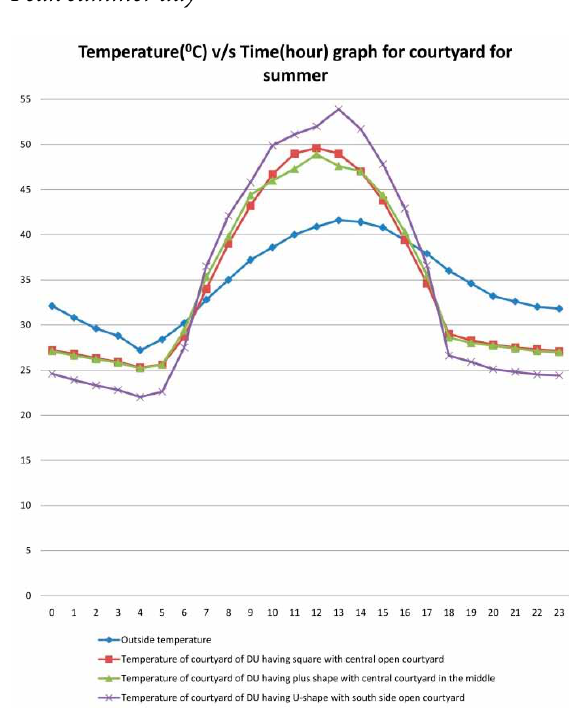
fig. 19. Temperatures over a 24 hour period in the courtyard on 29 th May, in all the three dwellings, summer day